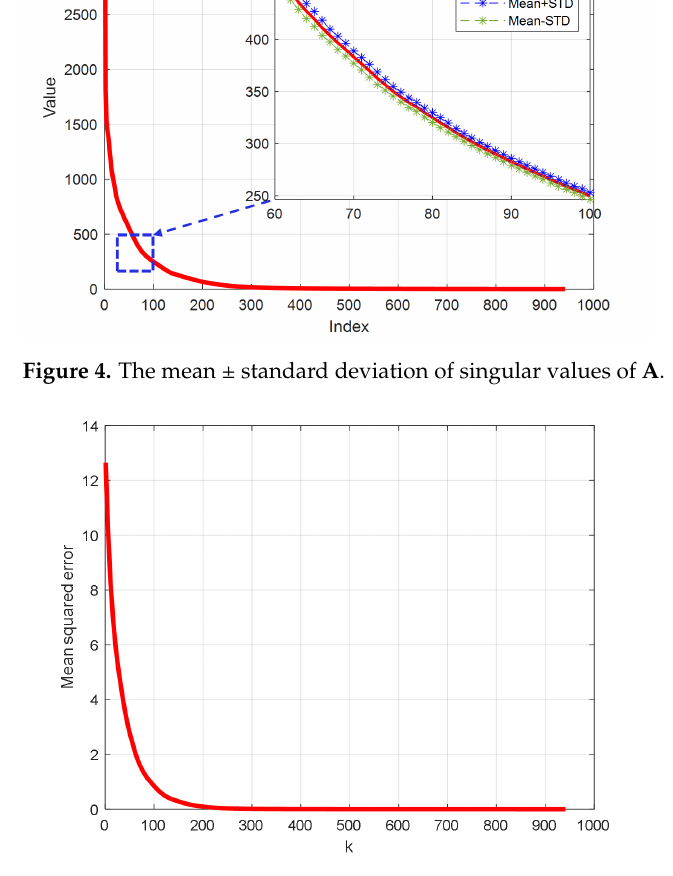
Figure 5. MSE versus k